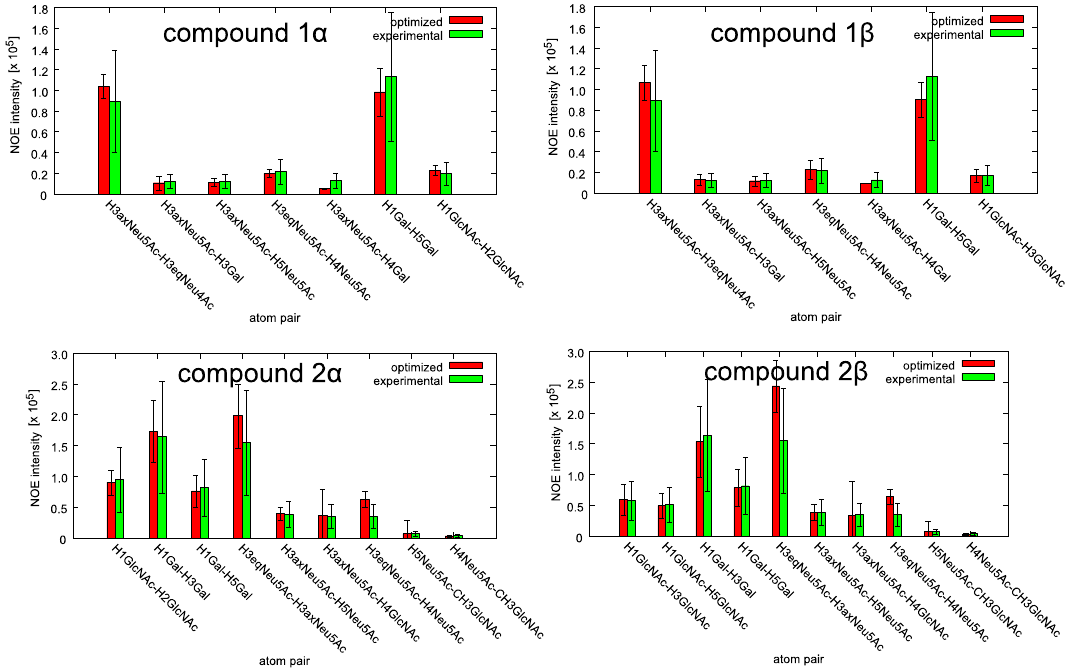
Figure 2. The experimental NOE intensities (green bars) are compared with those back-calculated from the molecular dynamics (MD) simulation after the optimization algorithm (red bars) for compound 1 (upper panels) and 2 (lower panels).